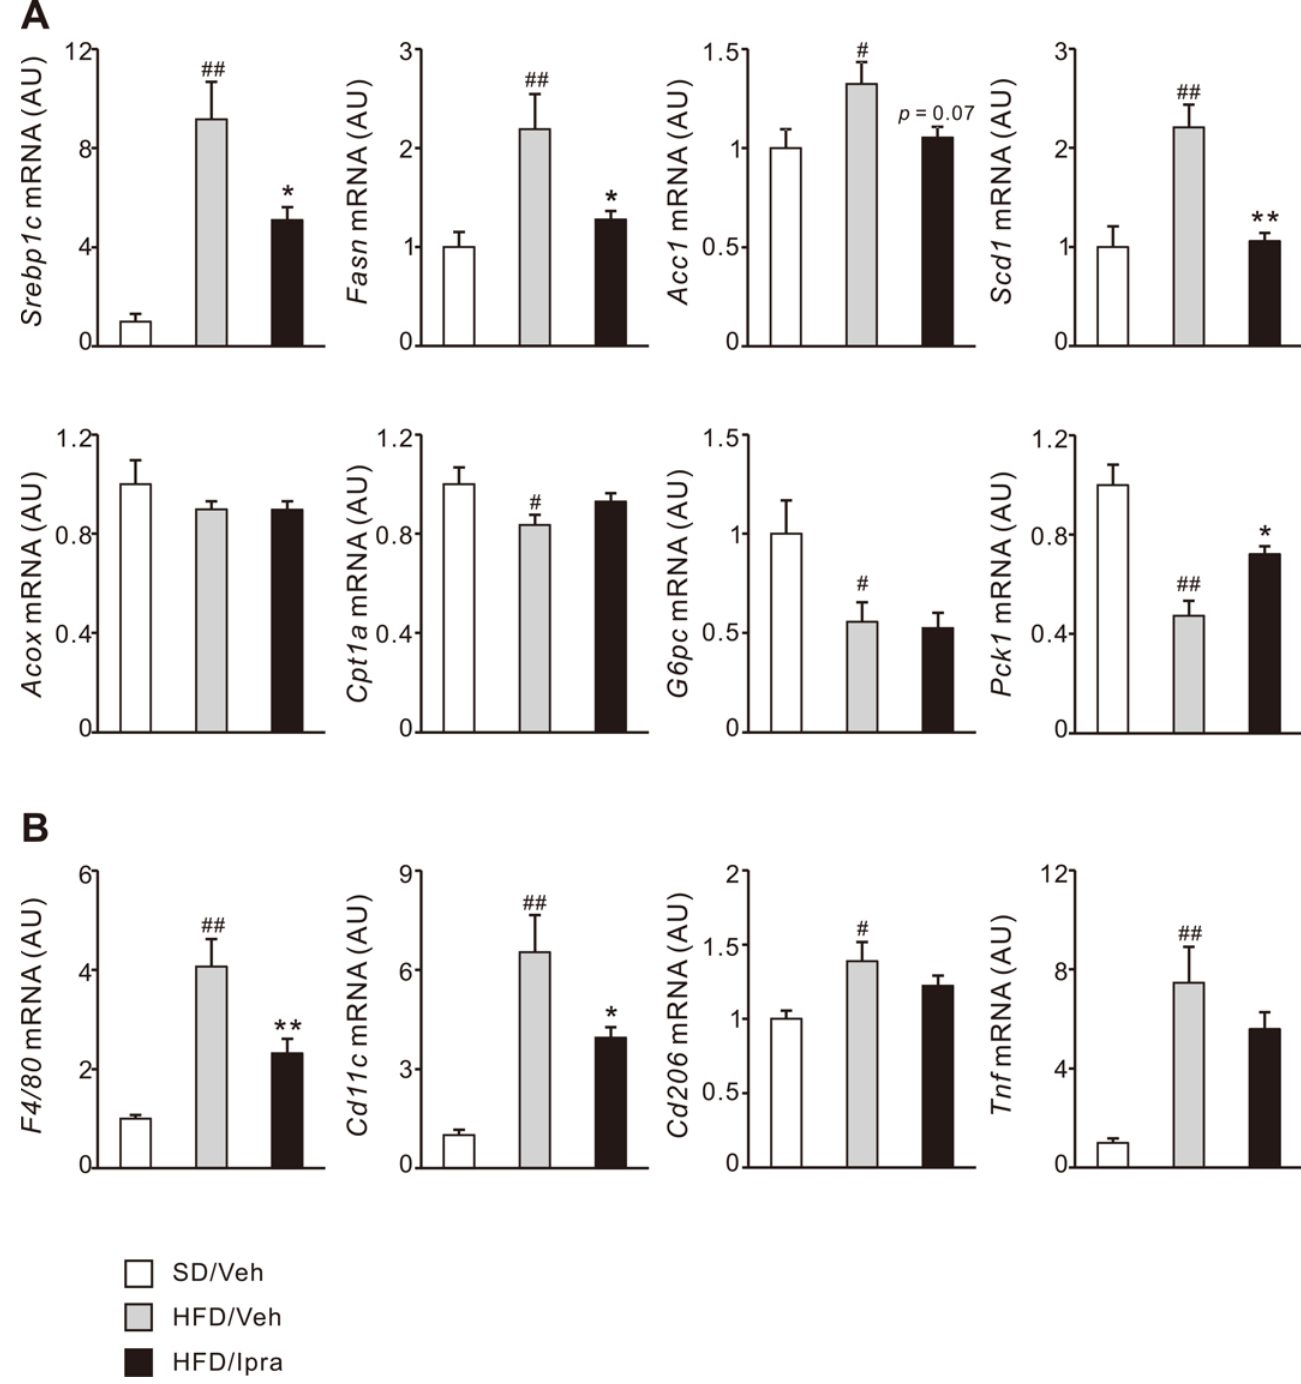
Fig 2. Effect of ipragliflozin on liver gene expression in HFD-fed WT mice. Gene expression levels in the liver associated with (A) lipogenesis, β - oxidation, gluconeogenesis, and (B) inflammation after 4 weeks of the vehicle or ipragliflozin treatment. # p < 0.05, ## p < 0.01 vs SD/Veh; * p < 0.05, ** p < 0.01 vs HFD/Veh. n = 6 –